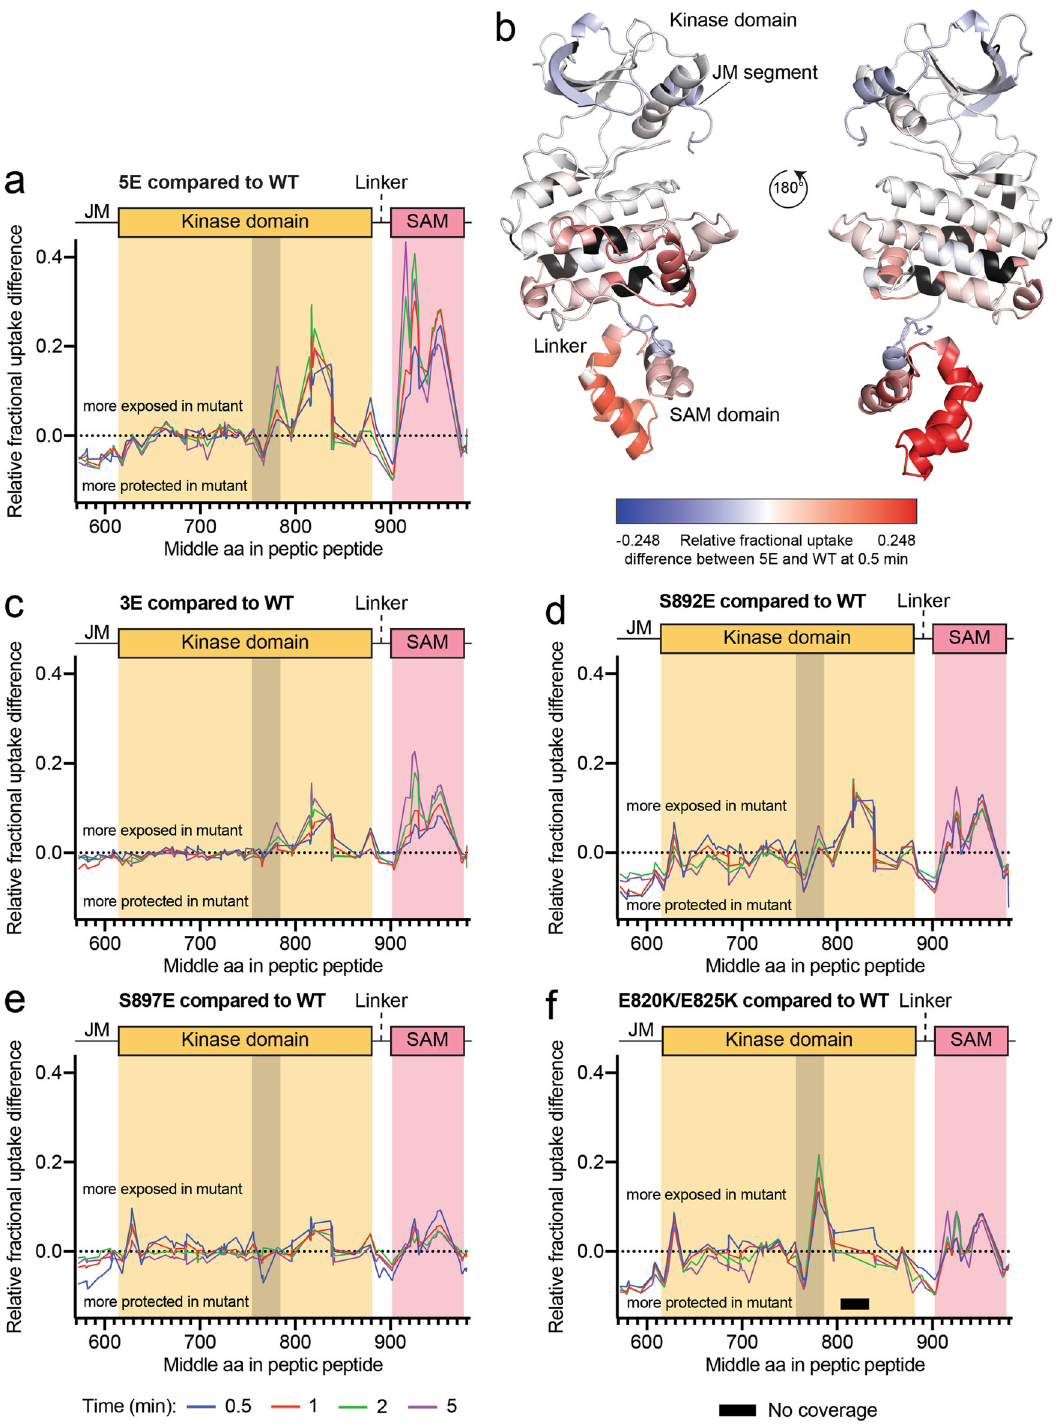
Fig. 5 HDX-MS analysis of the EphA2 intracellular region with kinase-SAM linker phosphomimetic mutations. a Fractional deuterium uptake difference plot comparing the EphA2 5E mutant with EphA2 WT after 0.5, 1, 2 and 5 min of exchange. Positive values indicate more rapid exchange in the 5E mutant compared to WT, whereas negative values indicate slower exchange in the mutant compared to WT. The gray shaded area indicates the activation loop (D757-E787). b Relative fractional deuterium uptake differences between WT and the 5E mutant after 0.5 min mapped onto the EphA2 WT structure (molecule B). Relative fractional differences from − 0.248 (less exposed in the 5E mutant) to 0.248 (more exposed in the 5E mutant) are colored in a gradient from blue to red. Residues without coverage are colored in black. c – f Graphs as in panel a , comparing fractional deuterium uptake differences between the indicated EphA2 mutants and EphA2 WT. The gray shaded area indicates the activation loop (D757-E787) and the black bar in f indicates a region without peptide coverage in the E820K/E825K mutant. Source data for a , c , d , e , f are provided in the Source Data fi